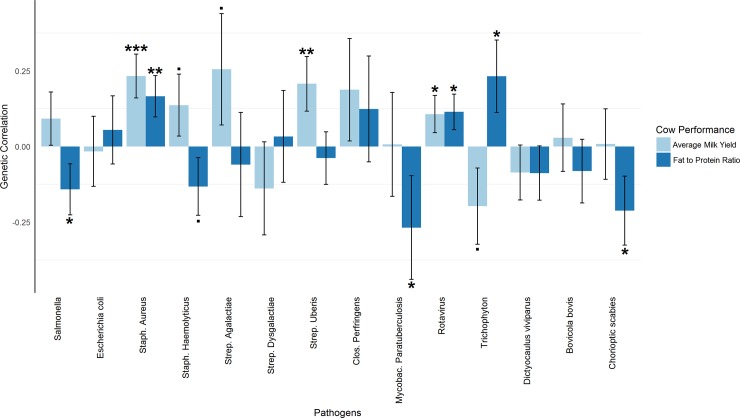
Estimated genetic correlations of average milk yield (AMY) and fat to protein ratio (FTP) with all resistance traits in cows.This plot compares the genetic correlation between AMY and all calf resistance traits with the genetic correlation between FTP and all calf resistance traits obtained from G-REML. The horizontal axis indicates pairs of phenotypes (AMY and FTP), and the vertical axis indicates genetic correlation. Error bars represent standard errors. ‘***’P ≤ 0.001; ‘**’P ≤ 0.01; ‘*’P ≤ 0.05; ‘·’P ≤ 0.1.